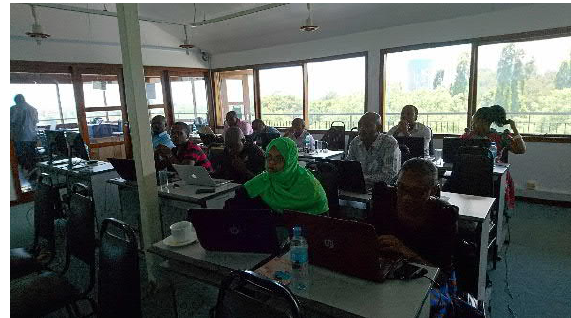
Figure 5. Basic GIS training at Ardhi University for UDSM, ARU, SUA and SUZA teachers and researcher using QGIS (November